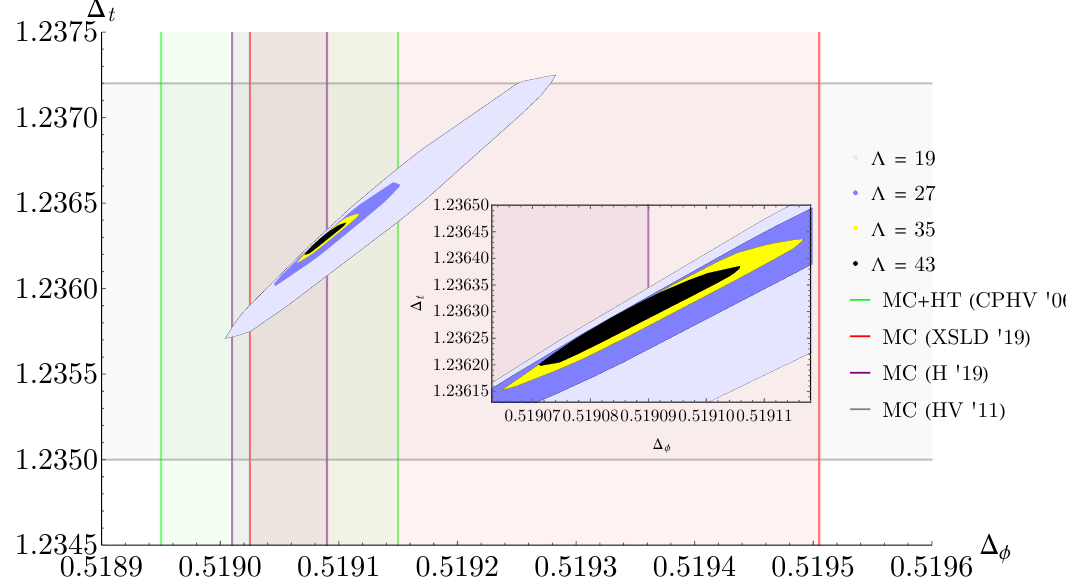
Figure 11 . New O(2) islands using the f (cid:30) i ; s; t ij g system and OPE scans at (cid:3) = 19 ; 27 ; 35 ; 43. This plot shows the projection to the f (cid:1) (cid:30) ; (cid:1) t g plane. The results for (cid:1) (cid:30) are compared with the recent Monte Carlo studies [86, 95] and an earlier study combining Monte Carlo simulations with high temperature expansion calculations [96], while the results for (cid:1) t are compared with